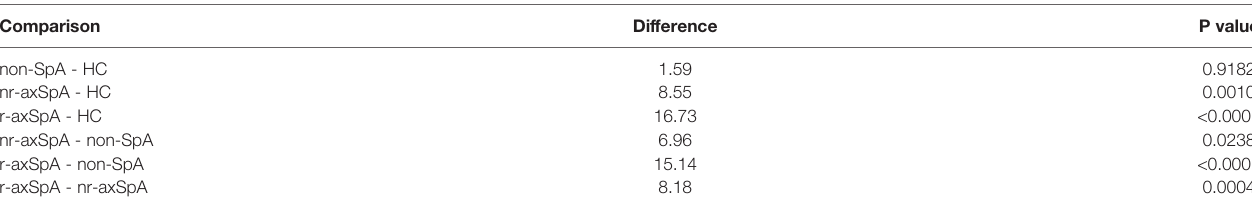
TABLE 3 | Pair-wise analysis of differences of PDFF values in different diagnostic groups. Comparison